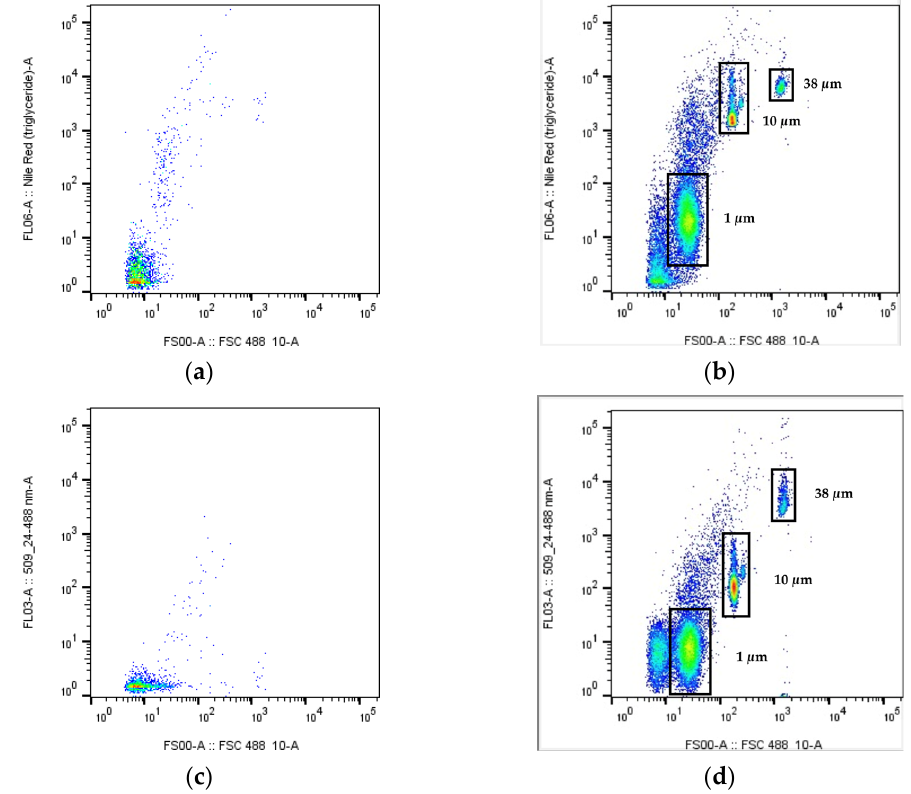
Figure 1. Flow cytometric NR fluorescence vs. FSC signal plots of ( a ) reagent blank composed of Tween 20 at 0.1% ( w / v ) in ultrapure water stained with NR, with emission filter at 583 nm; ( b ) PS calibration beads with size of 1, 10 and 38 µm in ultrapure water stained with NR, with emission filter at 583 nm; ( c ) reagent blank composed of Tween 20 at 0.1% ( w / v ) in ultrapure water stained with NR, with emission filter at 509 nm; and ( d ) PS calibration beads with size of 1, 10 and 38 µm in ultrapure water stained with NR, with emission filter at 509 nm. All the signal plots without any gating applied.